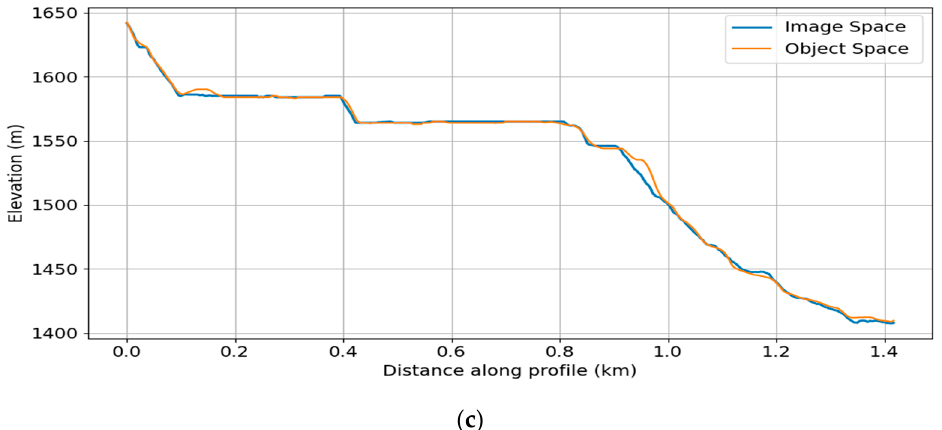
Figure 9. ( a ) Shaded DEM of the Morenci Mine are computed using SGM in the image space from tri-stereo SkySat images acquired on 1 January 2019; ( b ) Example of sub-scenes covering the area. ( c ) Profile along the transect (AA ’ ) extracted from image space DEM and object space DEM.